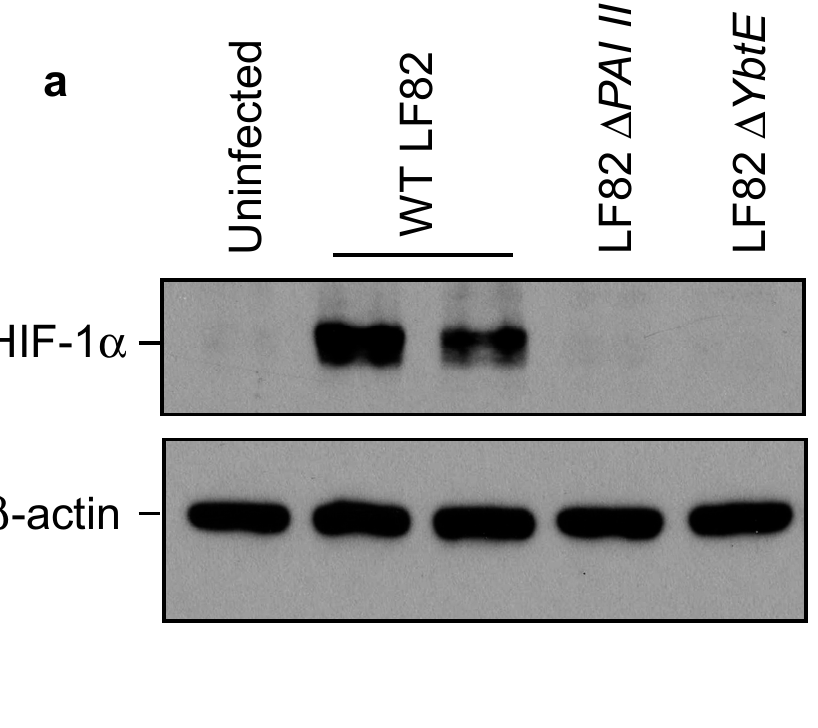
activation (Figure 6a). The decrease in autophagy activation in HIF-1 α -siRNA-transfected cells was correlated with an increase in LF82 intracellular replication (Figure 6b). Together, our results suggest that HIF-1 α controls AIEC LF82 intracellular replication by modulating host autophagy.